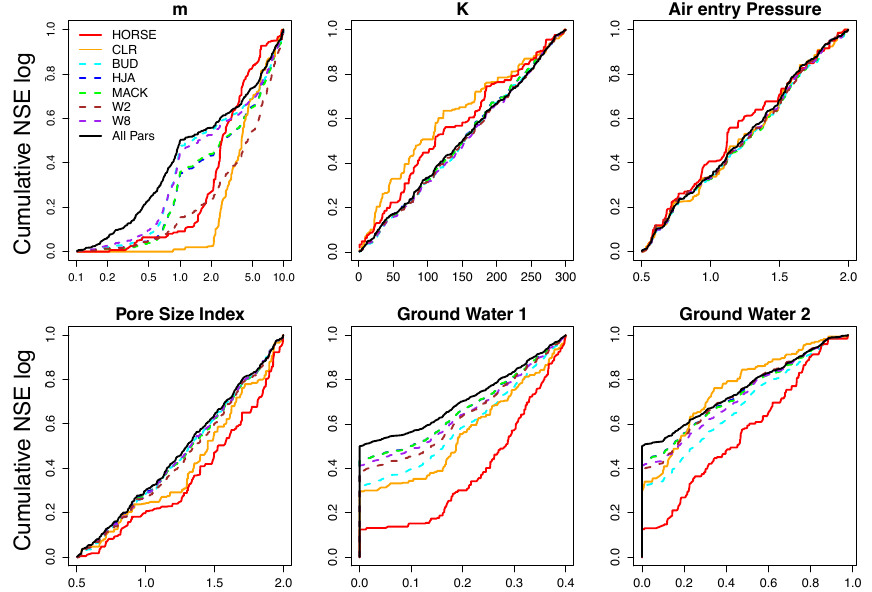
Fig. 3. Cumulative distribution of performance across parameter sets. The y-axis gives the cumulative probability of the performance measure (or parameter distribution). The x-axis gives the value of the parameter. Solid black line shows the original parameter distribution; colored lines show distribution of performance by parameter value for each watershed. Departures from the black line show preference for particular parameter